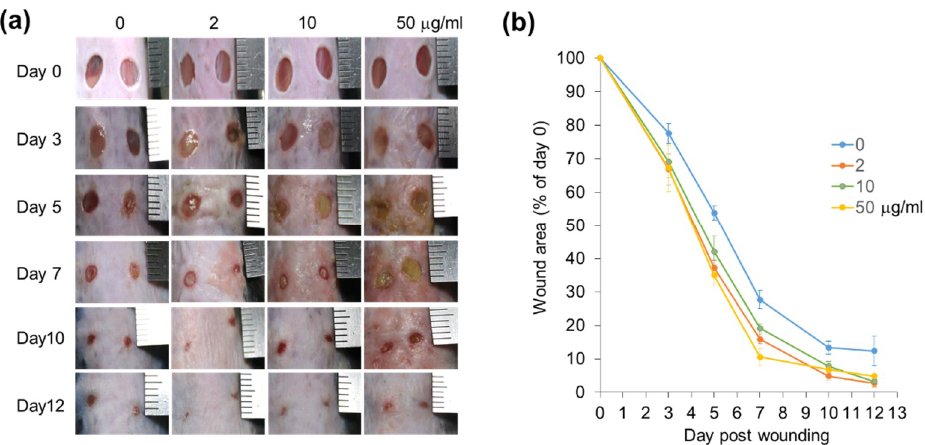
Figure 5. Effects of CJ extracts from fruit and stem on the wound healing process. ( a ) Rapid wound closure was observed in CJ -extract-treated wounds. Wounds treated with the indicated concentrations of extracts on days 0, 3, 5, 7, 10, and 12 were presented. ( b ) Wound areas in control and treated mice were determined by tracing the wound margin using a transparent sheet. The results were presented as the mean ± SEM ( n = 8) for each time point and group.